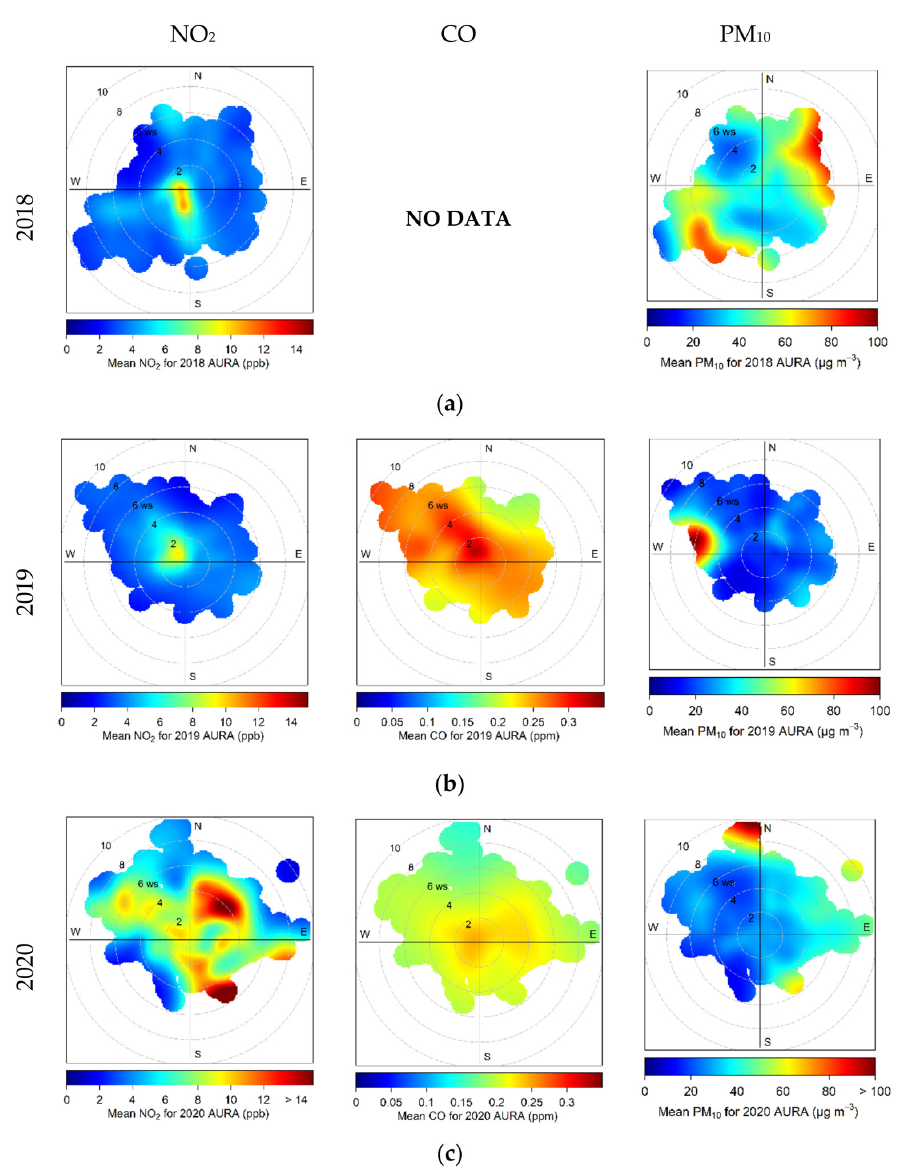
Figure A3. Bivariable polar plots for the three main pollutants NO 2 (left column), CO (centre column) and PM 10 (right column) of the AURA station for the ( a ) 2018, ( b ) 2019 and ( c ) 2020 study periods. Concentric circles record the wind speed, while the colour scale refers to the concentrations of